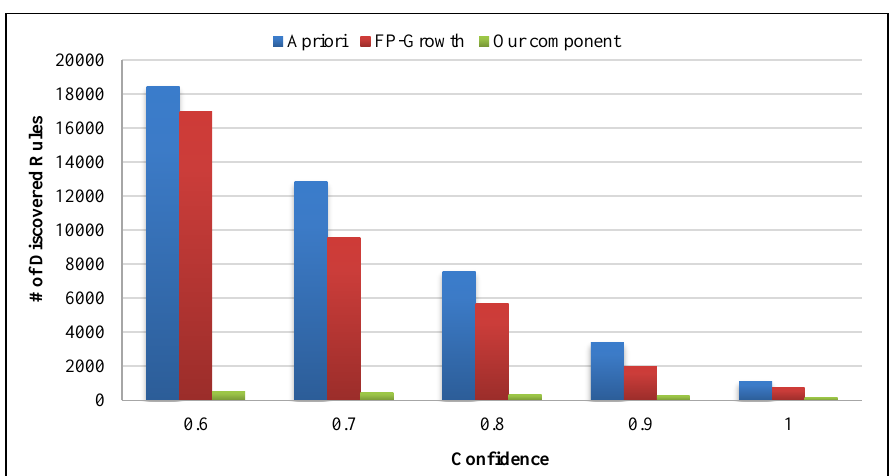
Figure 12. Rule number comparison for Breast Cancer data source